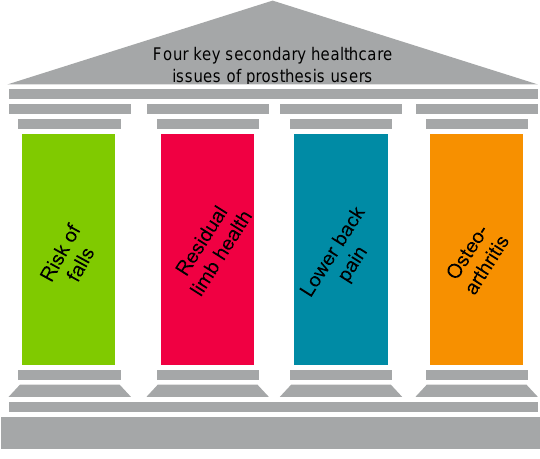
Figure 4 : Educational Need for future “Servitisation” – A four Pillars Model for Lower Limb Prosthetics Using Validated Patient Reported Outcomes (Diagram from Blatchford Institute)